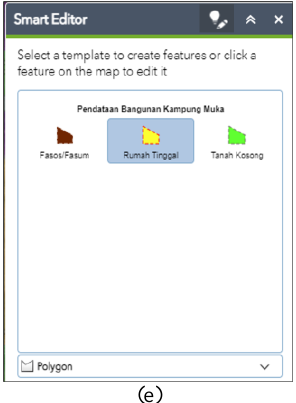
Figure 7 . Main tools in interface of Web-GIS application: